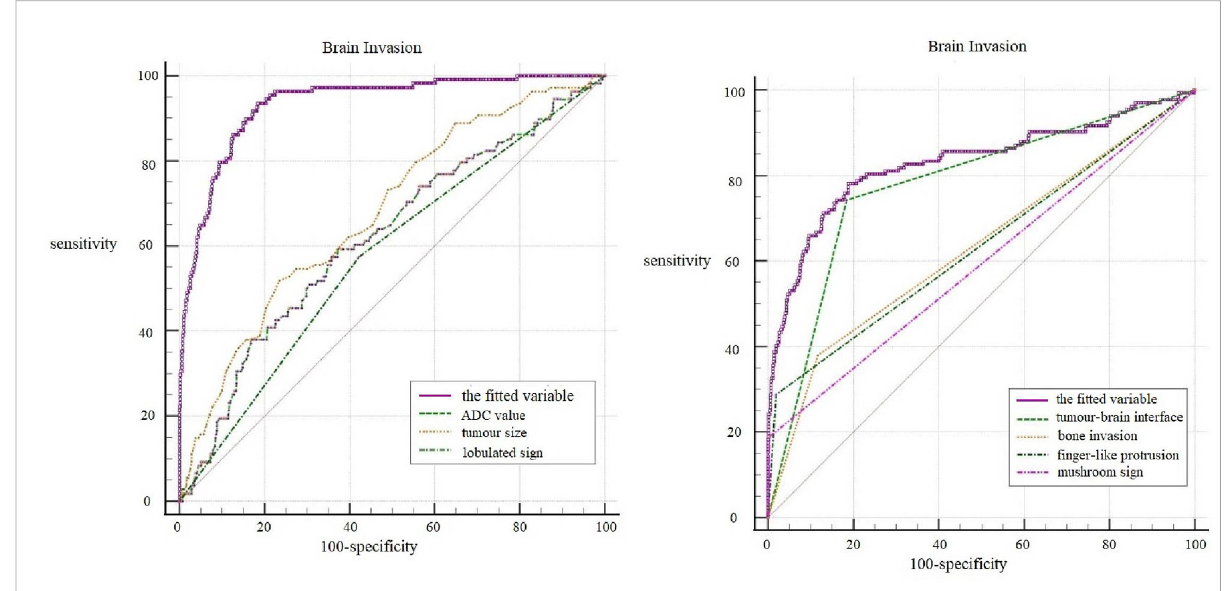
FIGURE 3 ROC curves of independent risk factors for brain